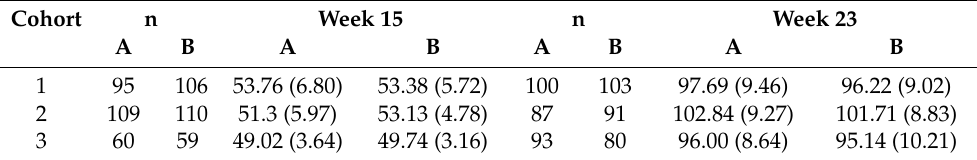
Table 1. Weights (kg; mean and SD) at indicated time points for animals of group A (IM vaccine) and group B (ID